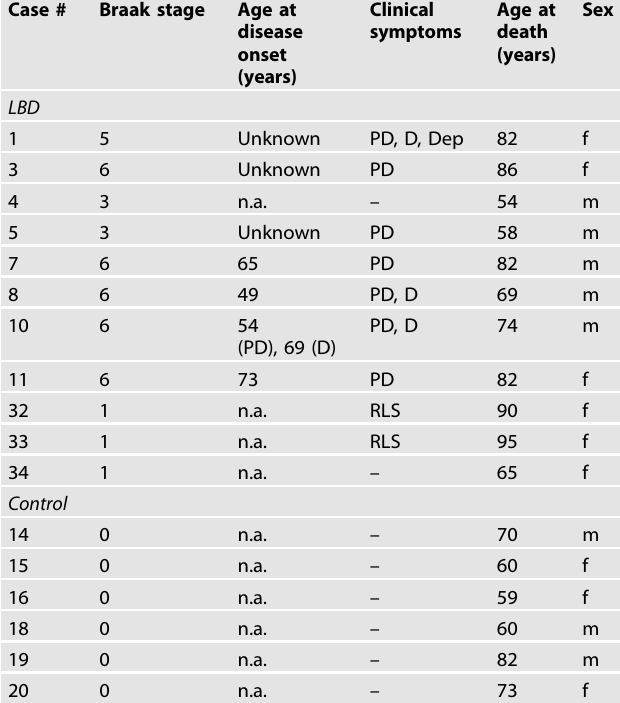
Table 2. Neuropathological characterization of brain tissue